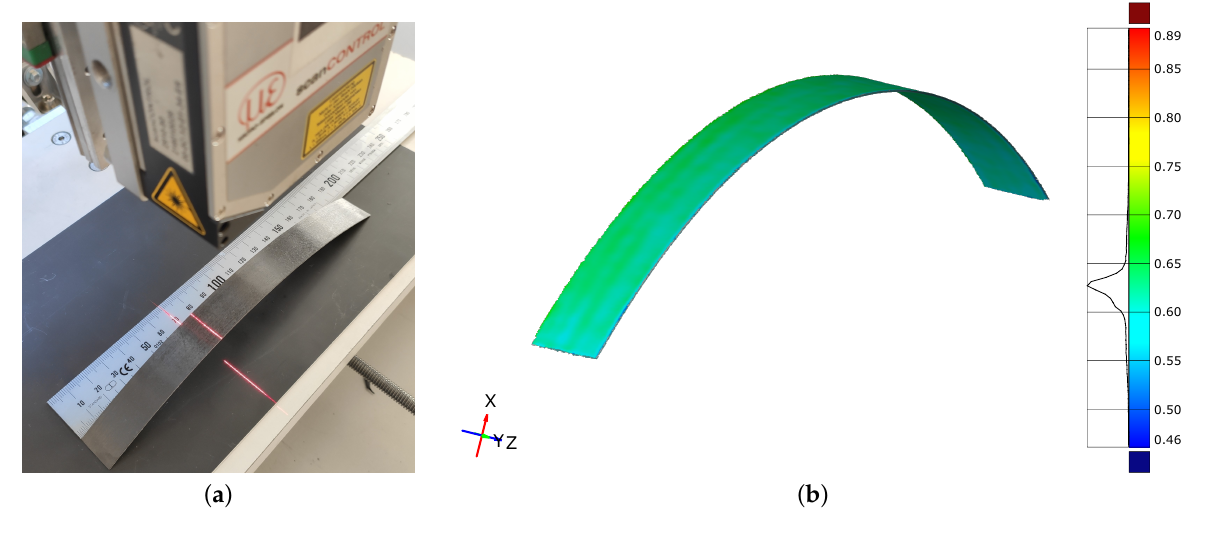
Figure 5. Measurement techniques for the curvature evaluation of asymmetric specimens: ( a ) laser distance sensor for specimen height evaluation; ( b ) 3D point cloud representation of a specimen with GOM ATOS (legend indicates the laminate thickness).